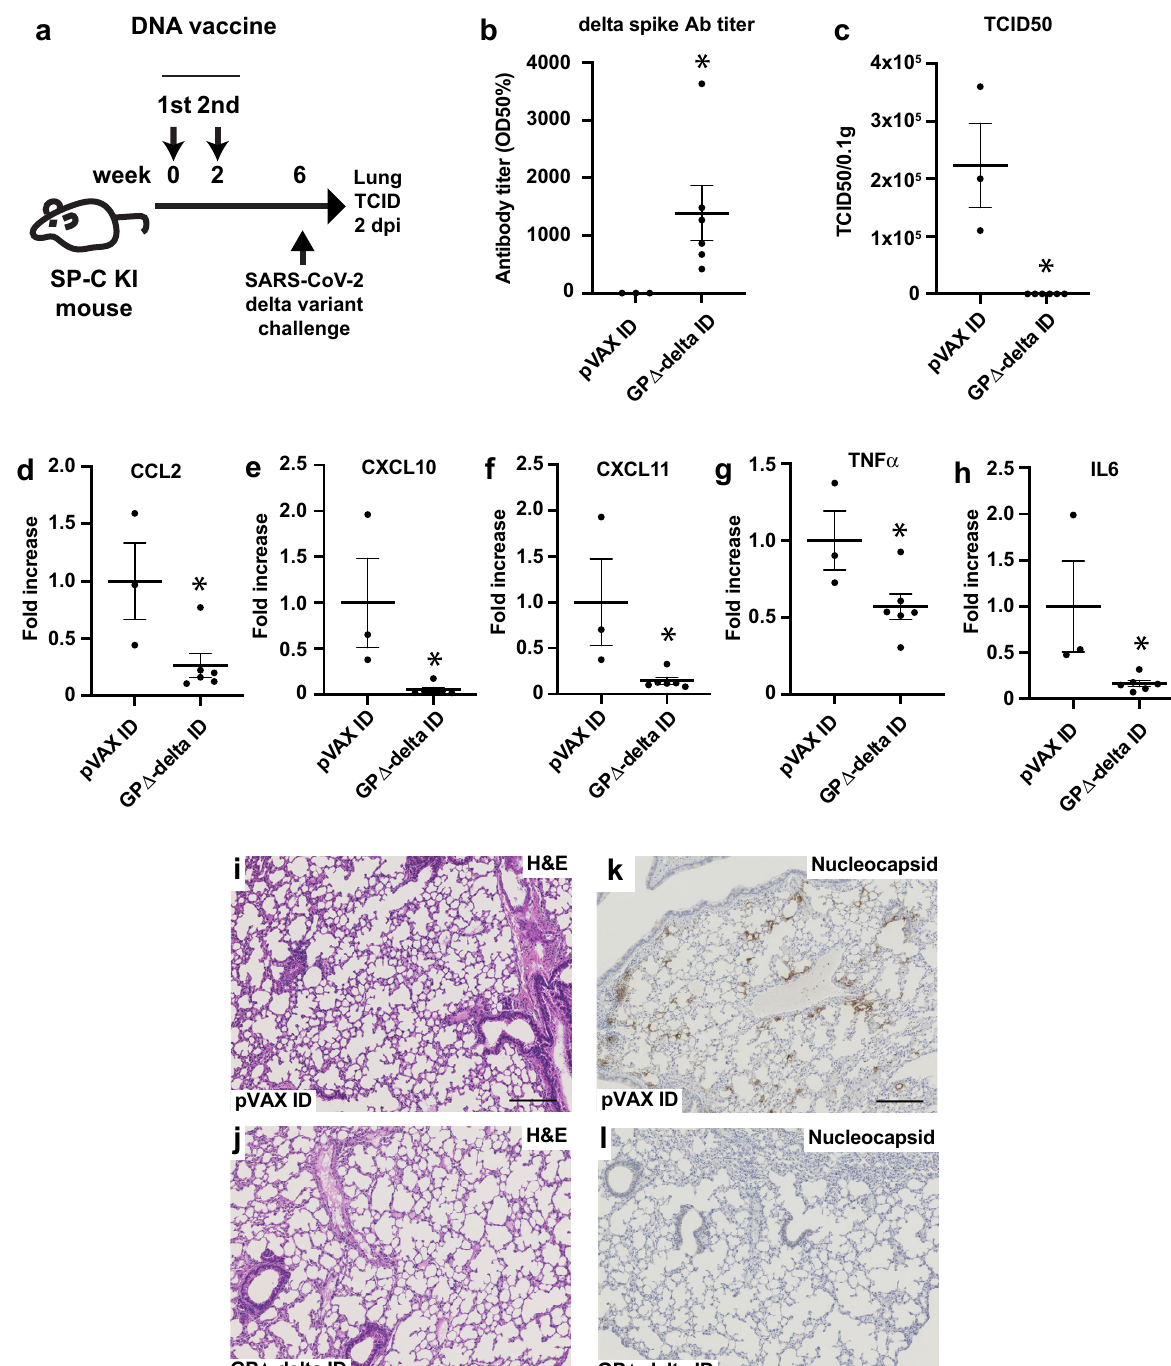
Figure 4. Intradermal administration of GP∆-delta DNA vaccine protects mice from SARS-CoV-2 delta variant infection. ( a ) Animal protocol for intradermal administration of the GP∆-delta DNA vaccine in female SP-C KI mice. The GP∆-delta DNA vaccine was intradermally injected through PJI two times at 2-week intervals. Six weeks after the first dose, the SARS-CoV-2 delta strain was challenged to mice via intranasal inoculation. Two days-post infection, the lungs were extracted to determine virus infection using a TCID assay. ( b ) Antibody titer specific for the delta variant spike, as determined through ELISA. *p < 0.05 vs. control pVAX ID group (Student’s t-test). ( c ) The viral load, which was determined through a plaque assay in the lungs at 2 dpi. *p < 0.01 vs. control pVAX ID group (Student’s t-test). ( d–h ) The inflammatory chemokines ( d ) CCL2, ( e ) CXCL10, ( f ) CXCL11 and cytokines ( g ) TNFα, ( h ) IL6 expression in the lungs after SARS-CoV-2 challenge was evaluated using real-time qPCR. The value was normalized through GAPDH expression. *p < 0.05 vs. control pVAX ID group (Student’s t-test). ( i , j ) H&E staining of the lung sections at 2 dpi following SARS-CoV-2 infection. Bar = 200 μm. ( i ) control mice, ( j ) vaccinated mice. ( k , l ) Immunohistochemical staining with SARS-CoV-2 nucleocapsid antibody, ( k ) control mice, ( l ) vaccinated mice. Bar = 200 μm. Data are shown as mean ± SEM. See also Supplementary Figs.